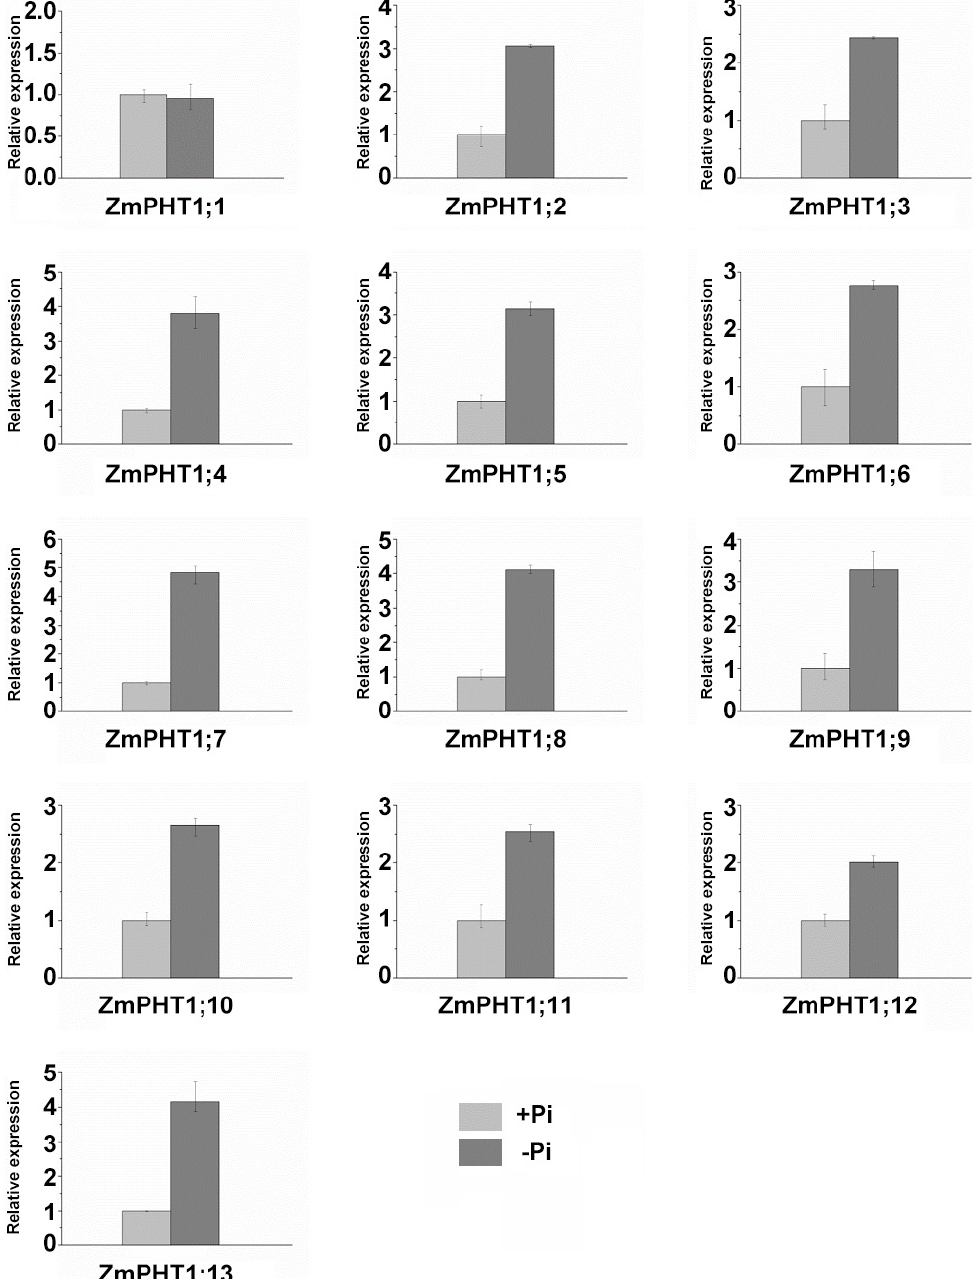
Figure 6. Expression pattern analyses of ZmPHT1 genes in root related to Pi availability. Maize was grown in nutrient solution containing 50 µM Pi and 5 mM Pi and sampled 40 days after treatment initiation. Data points are the means ± SD ( n = 3 biological replicates of three plants each).